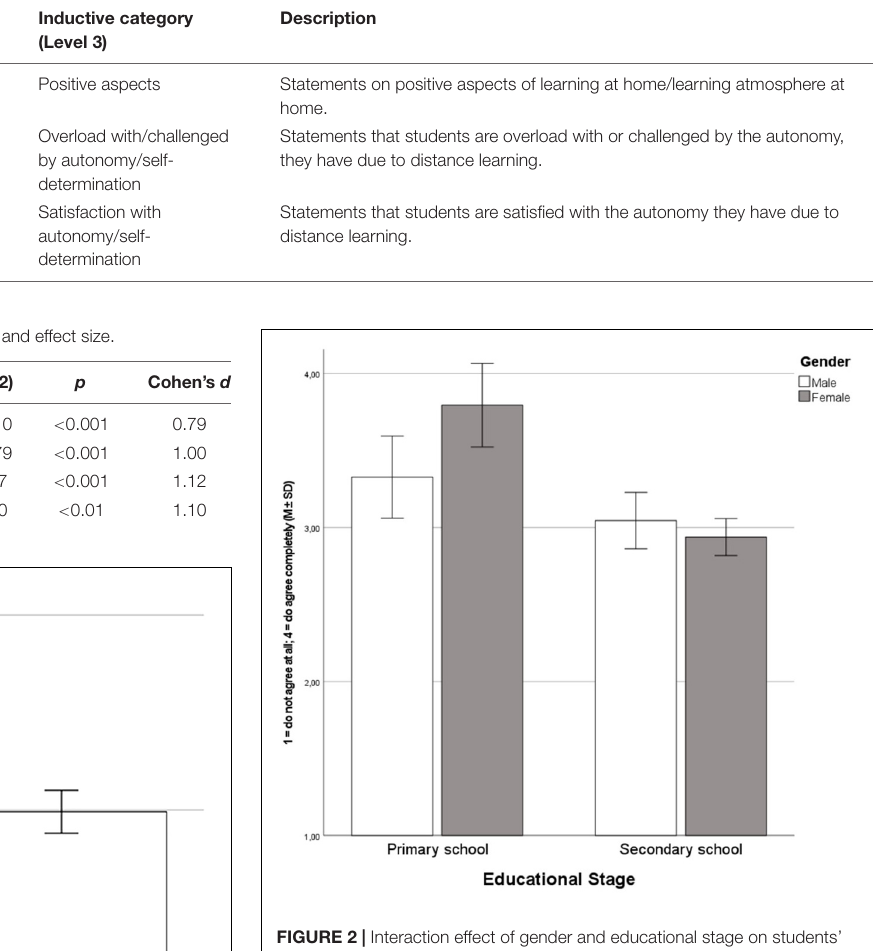
differentiation of the categories was generated